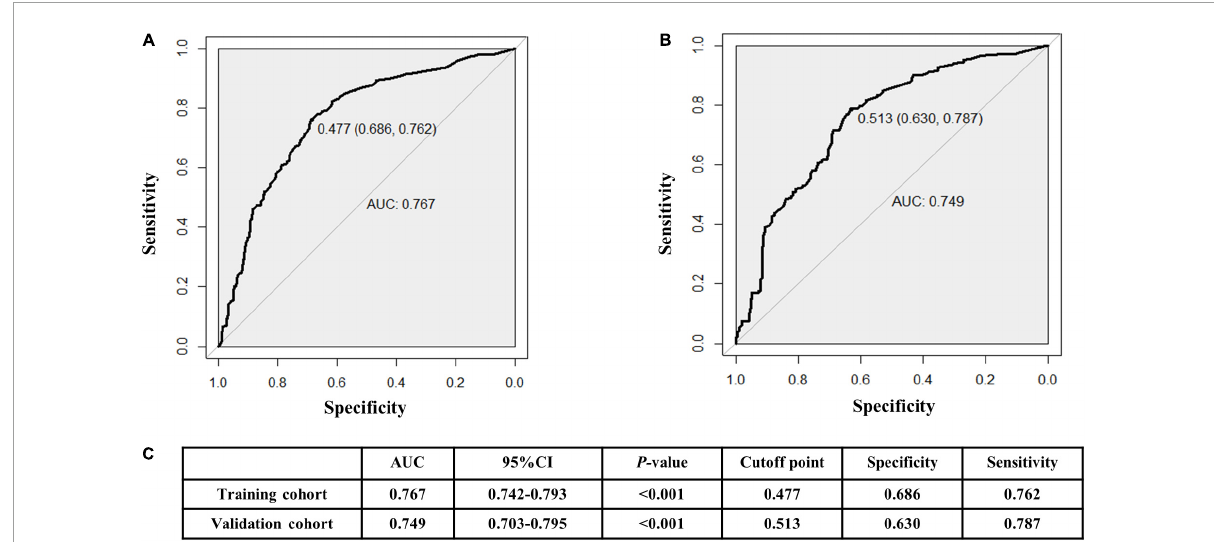
FIGURE8 Receiver operating characteristic (ROC) curves for the male training (A) and validation (B) cohorts. (C) illustrates some of the results of the ROC curve for the training and validation nomograms.